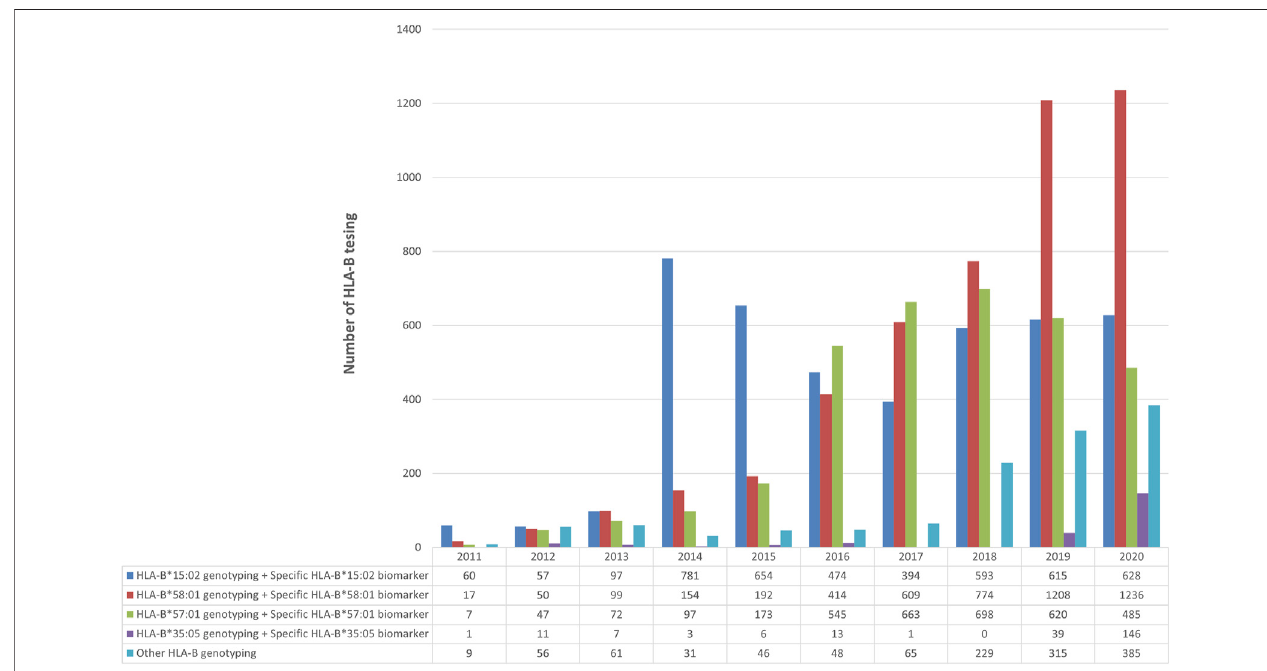
FIGURE 3 | Number of HLA-B -pharmacogenetic testing for (1) carbamazepine (2) allopurinol (3) abacavir (4) Nevirapine and (5) other drugs over 10 years during 2011 – 2020.